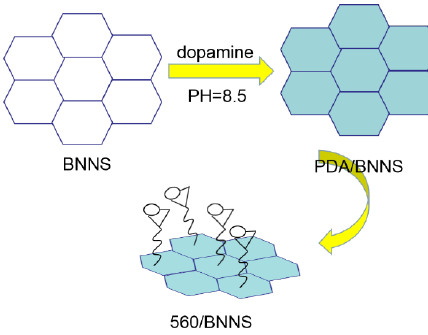
Figure 1. Schematic diagram of KH560 modified boron nitride nanosheets. Materials 2020 , 13 , x FOR PEER REVIEW